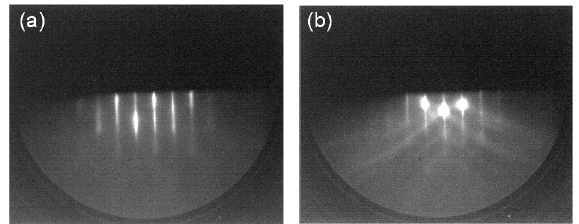
Figure 2. 110 azimuth RHEED patterns from ( a ) a GaAs (110) substrate after desorption of a native oxide, ( b ) a GaAs (110) cap layer on the MQW structure with T g = 580 °C. Both patterns indicate (1 × 1) non-reconstructed surface.